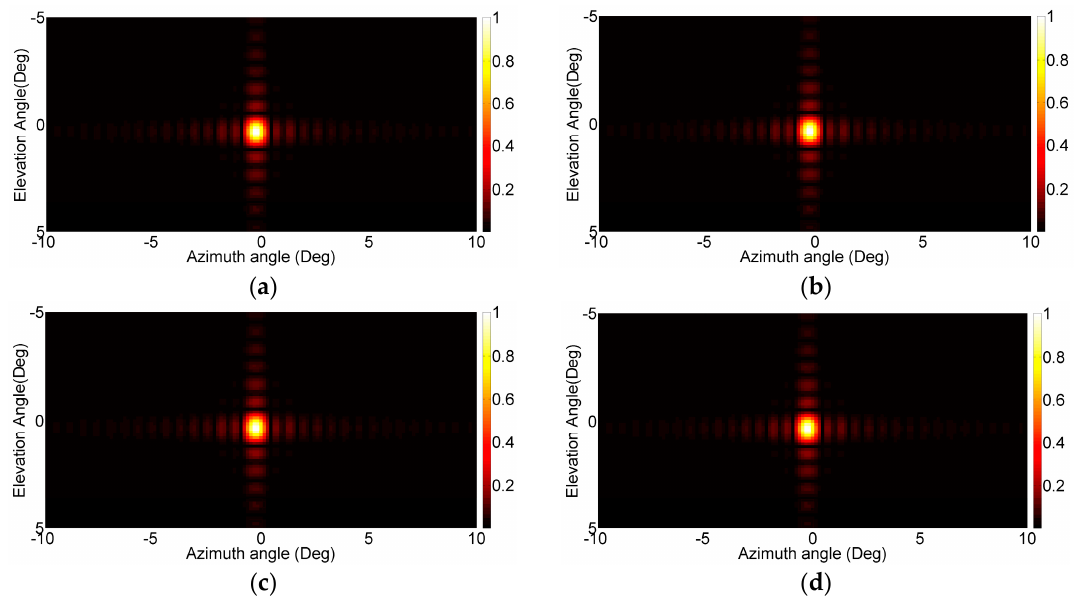
Figure 4. Results of 2D FFT based focusing algorithm in case of z 0 = 10 m ( a ); z 0 = 20 m ( b ); z 0 = 30 m ( c ) and z 0 = 50 m ( d ).